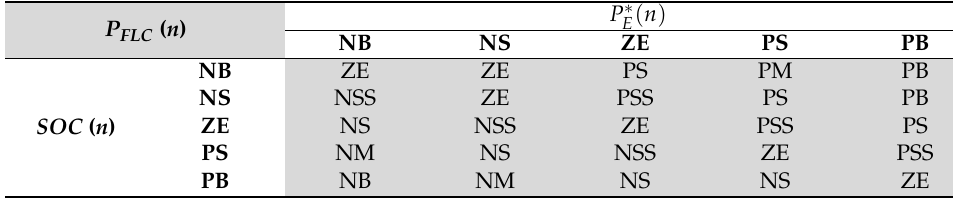
Table 3. Optimized rule base through Cuckoo Search (CS) algorithm [40,41].